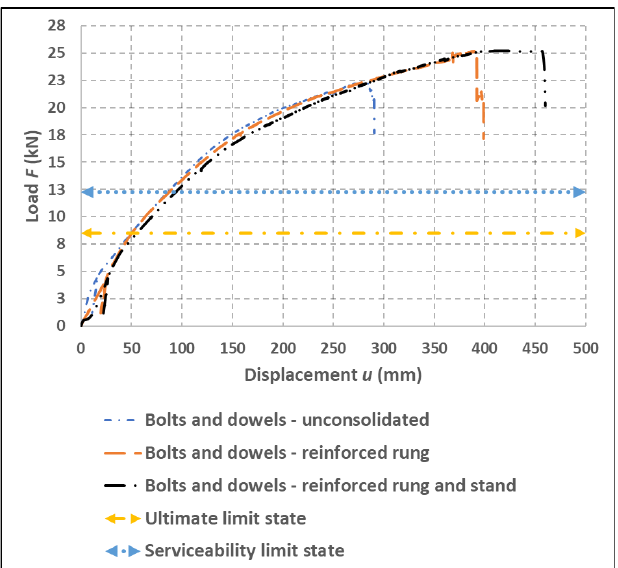
Figure 15. Load – deformation curves of individual specimens of static cyclic stress of experiment A, using bolts and dowels.